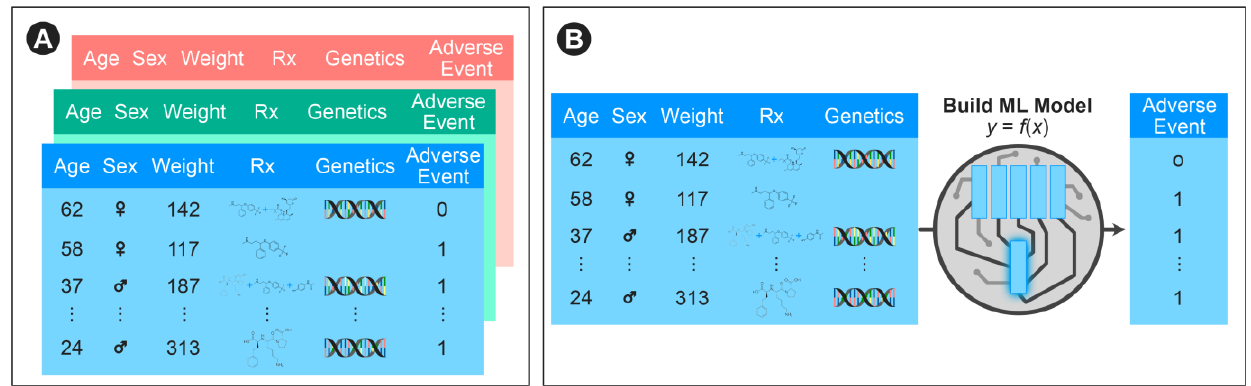
Figure 1. Overview of our approach: ( A ) Integration of multiple real world evidence databases including demographic, medication, and genetic information; ( B ) A machine learning model to predict adverse events is constructed.